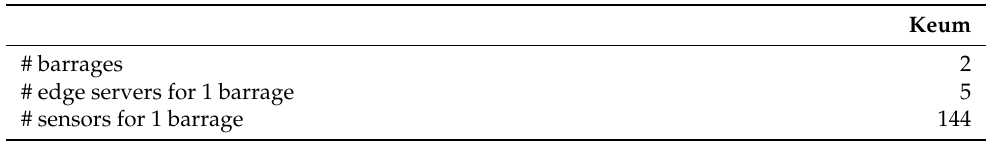
Table 1. Basic network component statistics in Keum